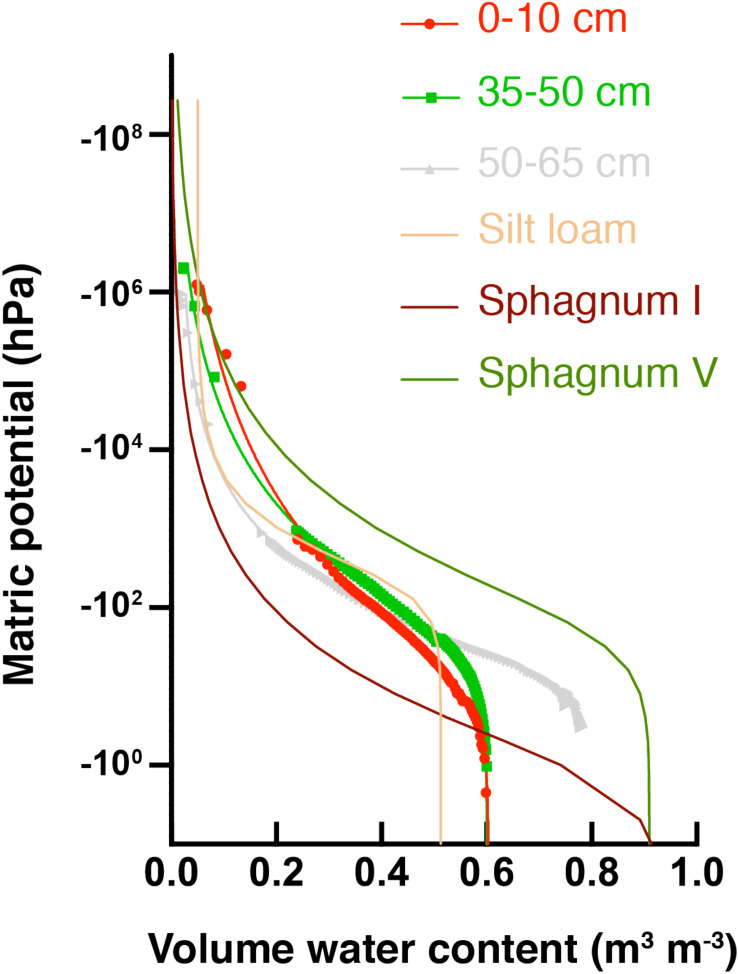
Soil water retention curves (SWRCs) for HCP center at different soil depths (red circles = organic, green squares = mineral, and gray triangles = permafrost). Parameters for reference curves for peat soils are from Liu and Lennartz (2019): group I sphagnum had a low bulk density (BD), while group V had a relatively high bulk density. Parameters for silt loam are from Or et al. (2012). Saturated water contents (θsat) are the volumetric water content (θv) at the highest Ψm.